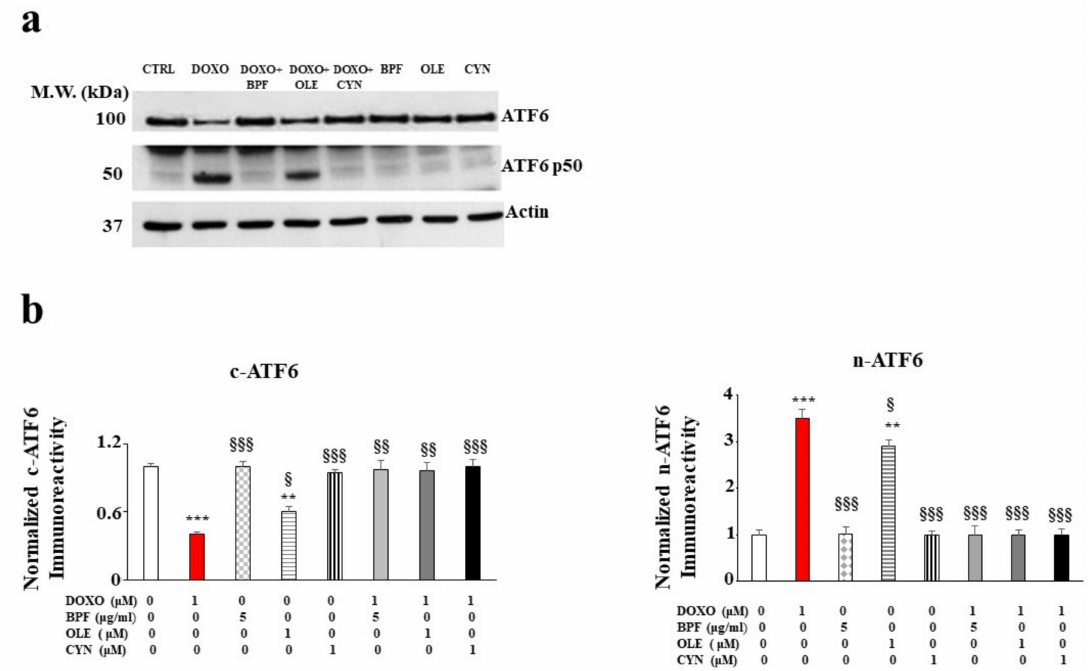
Figure 3. The role of ATF6 UPR arm activation. A representative Western blot of c-ATF6 and n-ATF6 modulation after pre-treatment with BPF (5 µ g/mL), OLE (1 µ M), or CYN (1 µ M) for 24 h and treatment with 1 µ M DOXO for 6 h is shown in panel a ). A graph showing the protein expression levels of c-ATF6 and n-ATF6 is presented in panel b ). The values of three independent experiments are expressed as the means ± standard deviations. ** denotes p < 0.01 vs. control; *** denotes p < 0.001 vs. control. § denotes p < 0.05 vs. DOXO; §§ denotes p < 0.01 vs. DOXO; §§§ denotes p < 0.001 vs. DOXO. The Analysis of Variance (ANOVA) was followed by the Tukey–Kramer comparisons